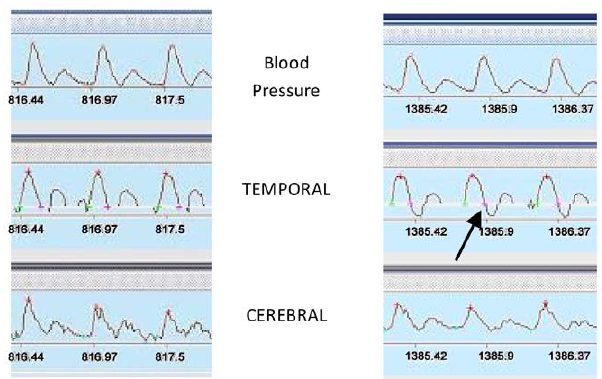
Figure 1. BP trace and TEMP and MCA normal flow velocity (at 2 1 min) on left panel. BP, MCA normal flow velocity, TEMP with negative diastole at 2 10 s before tilt arrest (arrow) on right panel.